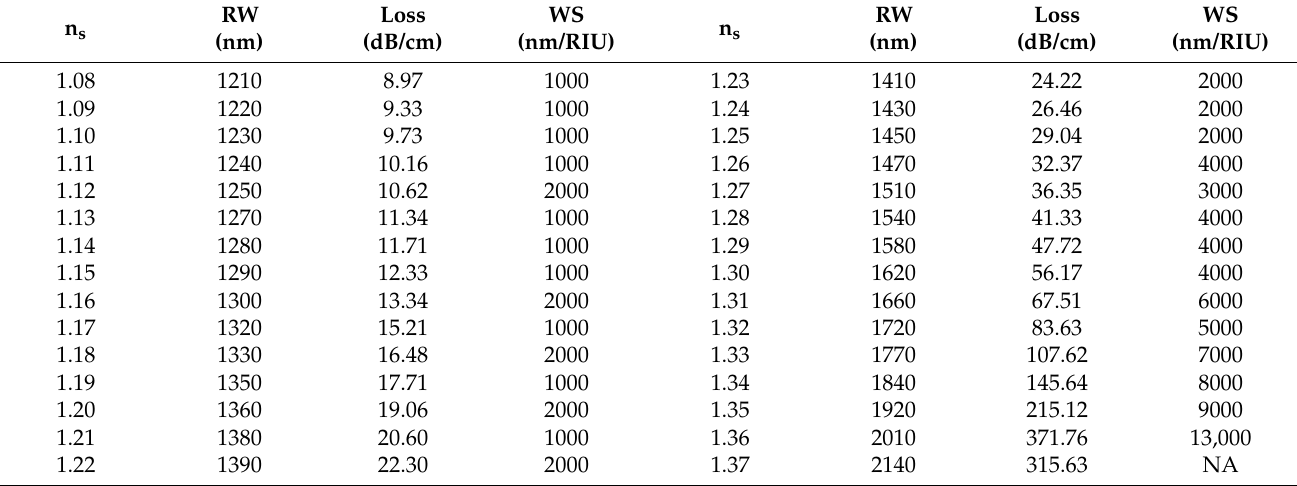
Table 1. Performance analysis of